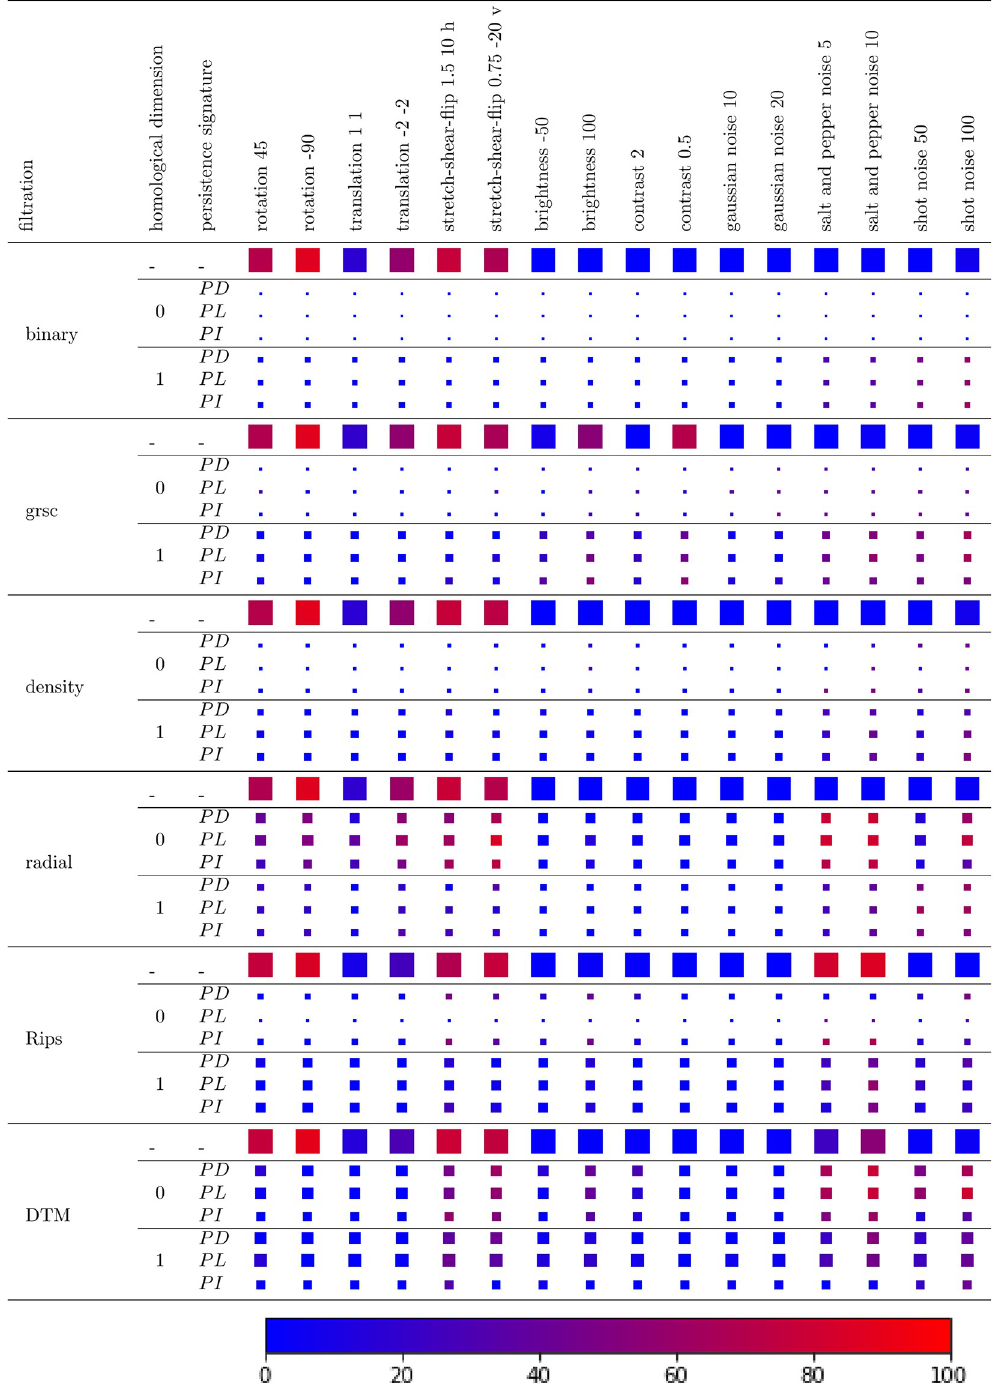
PLOS ONE | https://doi.org/10.1371/journal.pone.0257215 September 24,